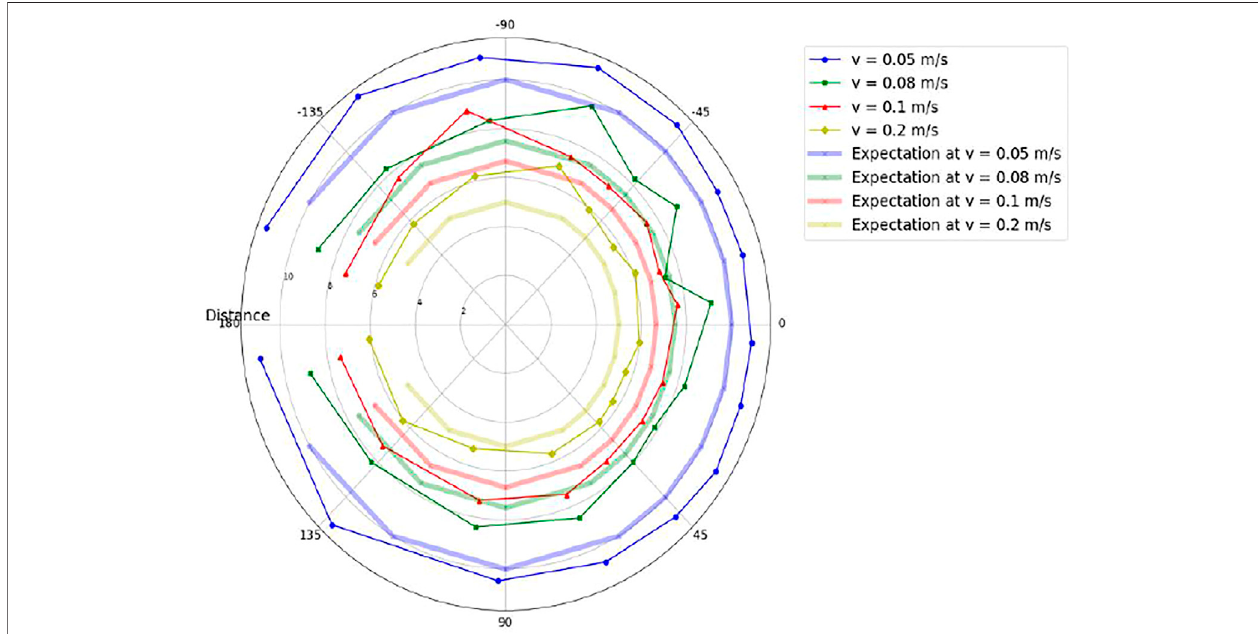
FIGURE 13 | Polar representation of Intended Destination Positions vs . Expected